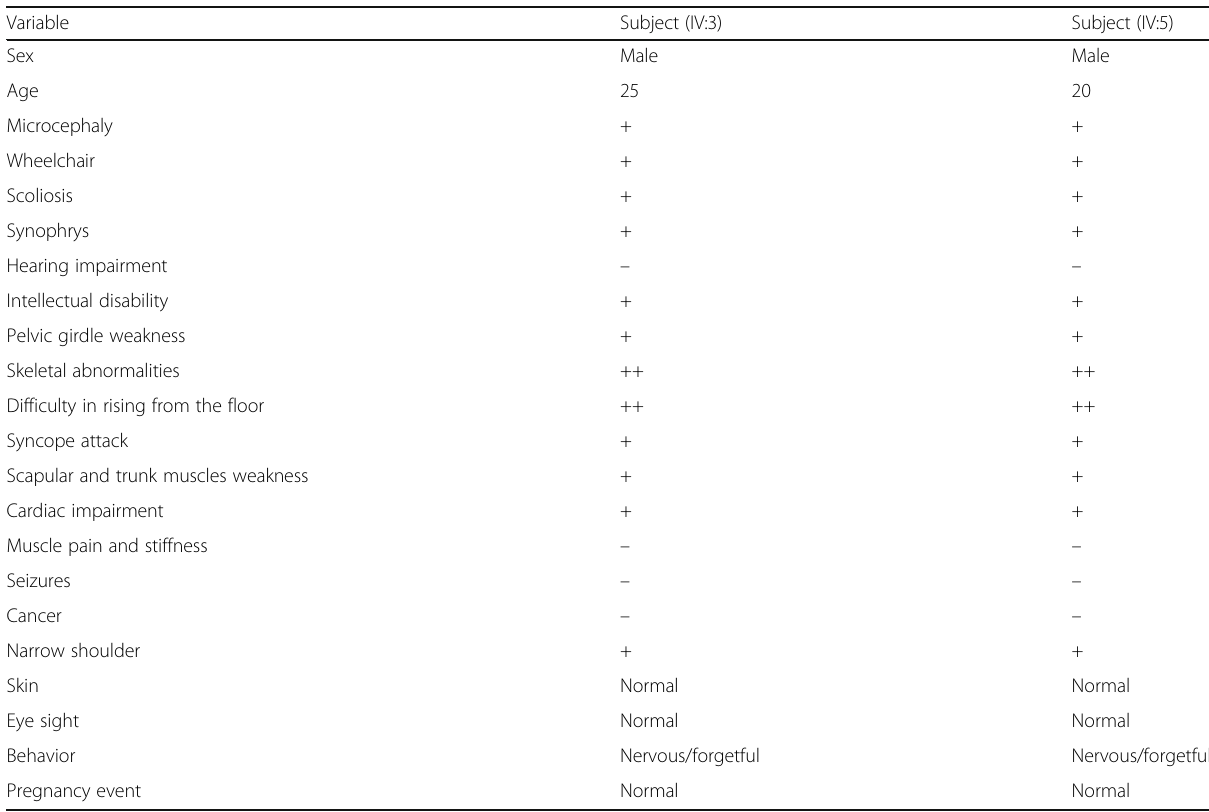
In the present study, clinical diagnosis was confirmed by genetic analysis. Of these, both patients (IV: 3; IV: 5) and their parents (III-1;III-2) were subjected to whole exome sequencing (WES) as described earlier using Ion Torrent platform [11 – 13]. WES results indicated a novel homozy- gous missense variant (c.98807G > A; p.Arg32936His) in TTN (MIM: 188840) gene responsible for LGMD pheno- type (Table 2). Sanger sequencing perfectly confirmed seg- regation of the disease phenotype. The variation G-to-A transversion results into the substitution of arginine (R) to histadine residues (Arg32936His). This mutation is